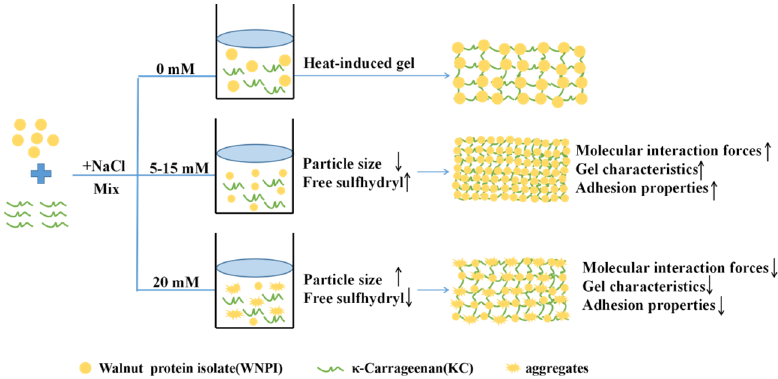
Figure 8. Schematic mechanism of WNPI-KC composite gel samples with NaCl.